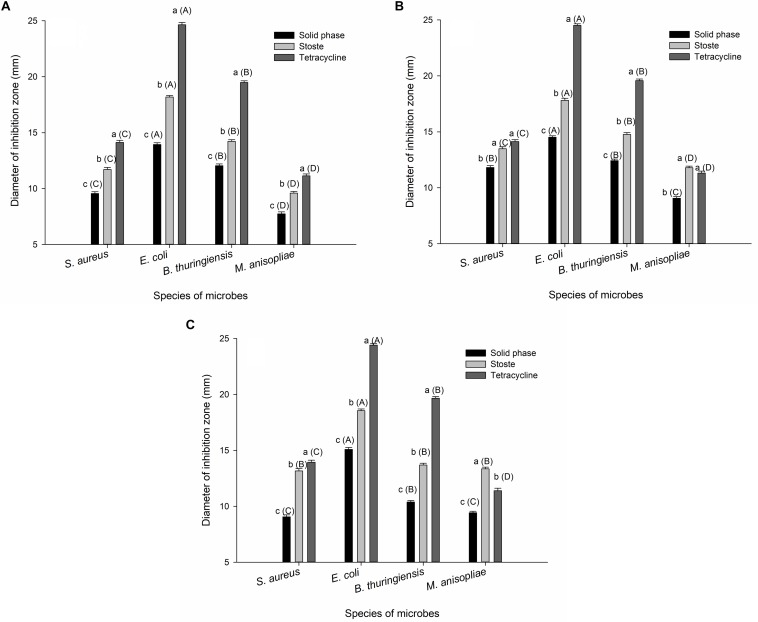
The diameter of the inhibition zone against microbes formed by (A) larval oral secretions, (B) larval abdominal secretions, and (C) adult abdominal secretions. The graph shows mean ± standard error. Different lowercase letters outside parentheses indicate significant difference among different treatments within the same tested microbe, while different uppercase letters inside parentheses indicate significant difference among different species of microbes under the same treatment, according to Tukey’s honestly significant difference (HSD) test of one-way ANOVA (P < 0.05).